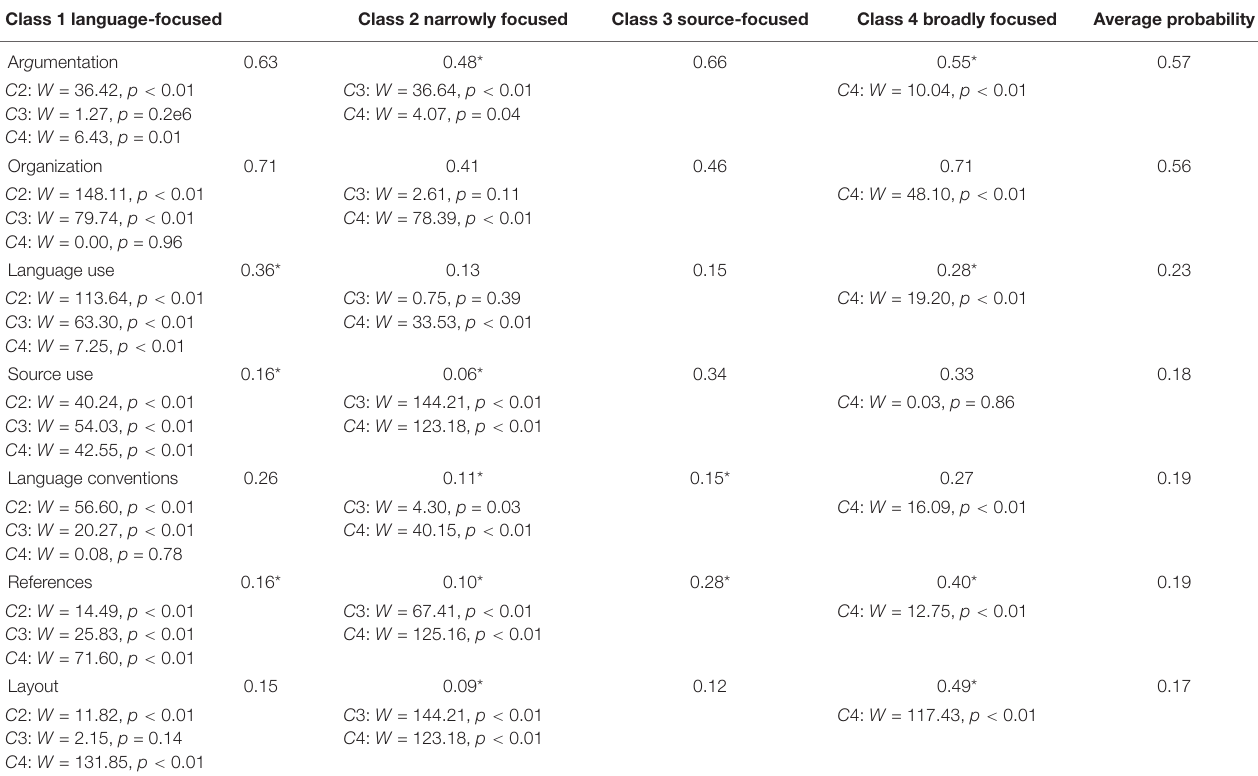
TABLE 4 | The probability that assessors w ithin a class refer to an aspect of text